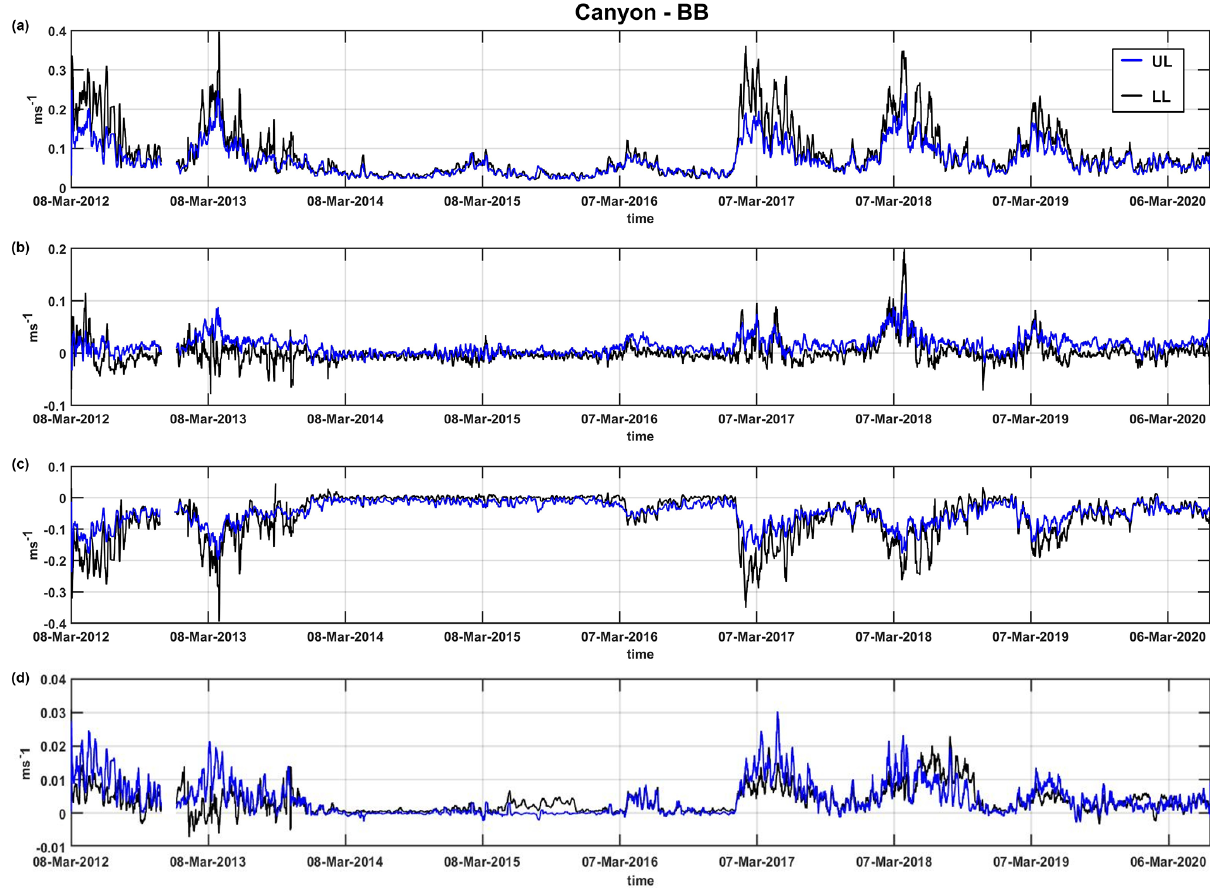
Figure 9. Time series of currents at BB site in the upper (UL) and lower layer (LL) of the water column: (a) speed, (b) east, (c) north and (d) vertical component – BB. The data are presented with a 7d smoothing